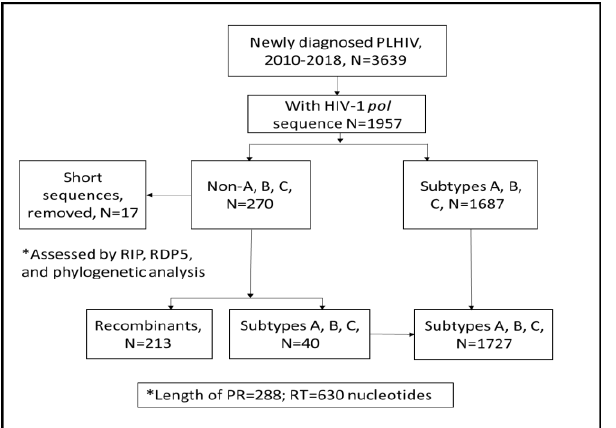
Figure 1. Identification of HIV-1 CRFs and URFs (recombinants) in 2010–2018. All PLHIV newly diagnosed in 2010–2018 (N = 3639) for whom sequencing data were available ( n = 1957) were included in the analysis as described in the Materials and Methods section. The RIP, RDP5, and phylogenetic analysis revealed that 213 of these sequences are non A, B, and C. RIP—Recombinant Identification Program; RDP5 — Recombinant Detection Program (version 5.5).